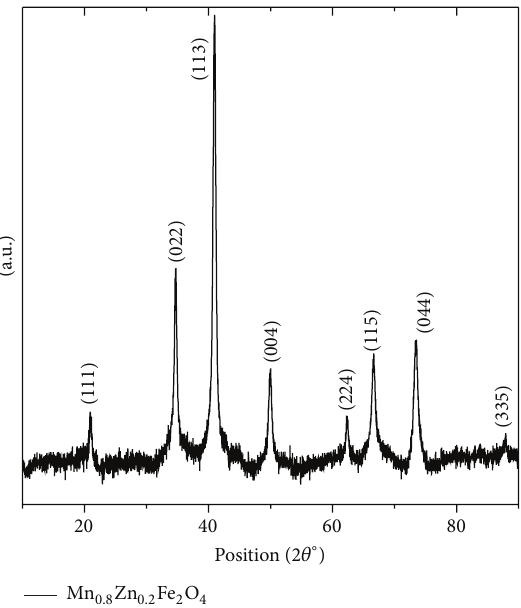
Figure 3: XRD pattern of Mn 0.8 Zn 0.2 Fe 2 O 4